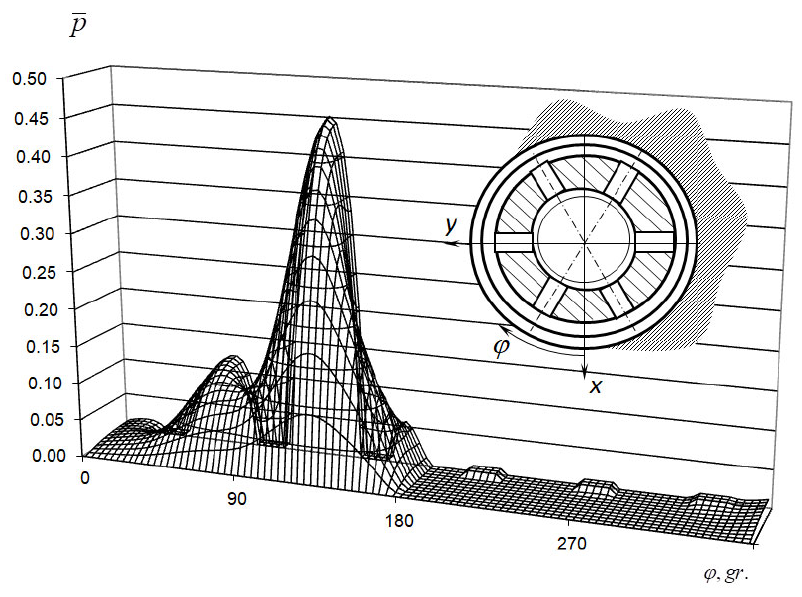
Figure 6. Diagram of hydrodynamic pressures in the lubricating layer with six holes.